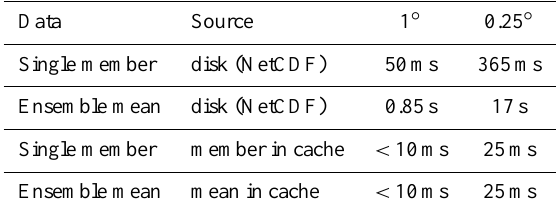
Figure 9. Hybrid sigma-pressure levels used by the ECMWF model. (a) The elevation of the model levels (green lines; the exam- ple shows levels from the 31 level model; level indices k in green) changes with surface pressure (black curve at the bottom). The data value for a given pressure value p can be located at different lev- els in the grid (the red line marks the location of p = 600hPa). (b) Example of how the surface orography affects the vertical displace- ment of the grid points in a vertical section. Table 1. Order of magnitude of response times achieved by Met.3D to display a new image after the user has advanced the forecast time for the horizontal section in Fig. 3b, displaying either data of a sin- gle member or of the ensemble mean (the latter an example of a statistic that requires all members of all variables when computed on demand). Timings are measured on the test hardware described in Sect. 3 and given for both forecast data at 1 ◦ grid spacing and at 0.25 ◦ grid spacing; 12 parallel threads are used by the scheduler for task graph execution. Fig. 3b uses four forecast variables, read- ing all ensemble members (for computation of the mean) from the disk hence involves reading 4 × 51 × 1 MB at 1 ◦ grid spacing and 4 × 51 × 16 MB at 0.25 ◦ grid